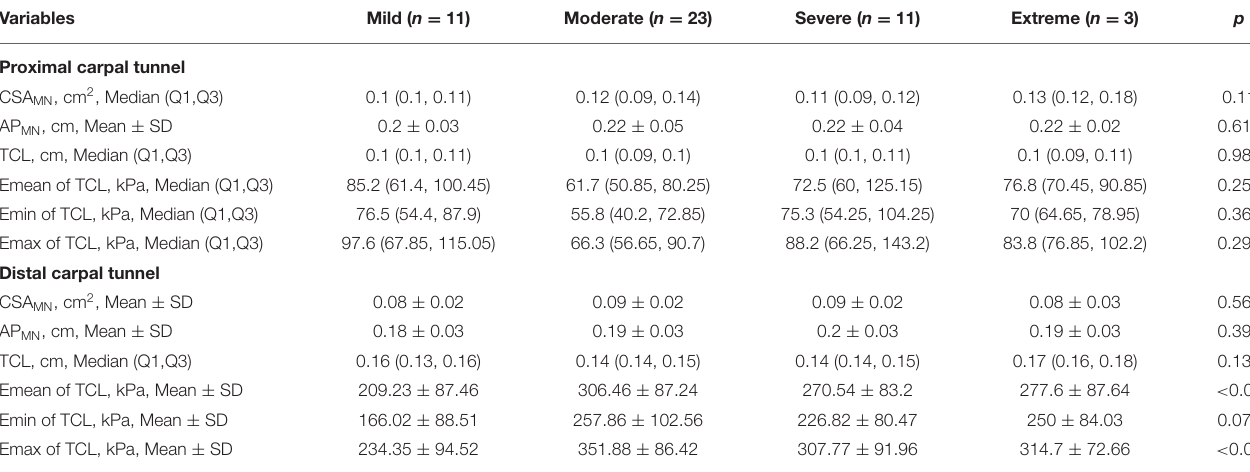
TABLE 4 | Comparison of MN (CSA and AP), TCL (thickness and stiffness) and NCS severity in the positive hand in the patient